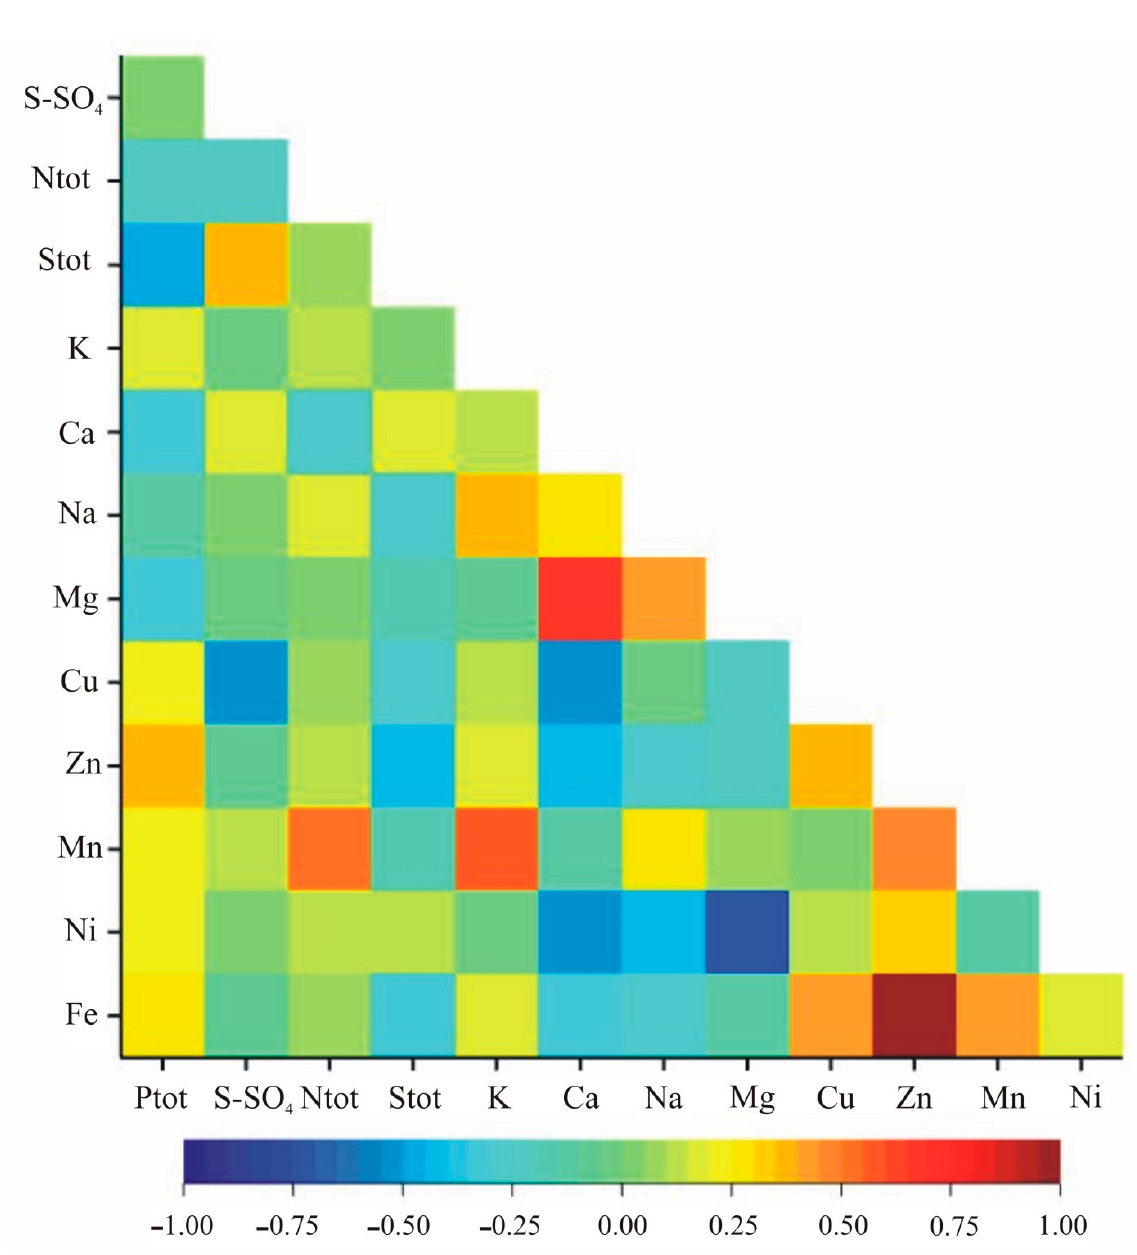
Figure 3. Heatmap for linear Pearson’ correlation coefficients between observed nutrients in the vegetative stage ( r cr =